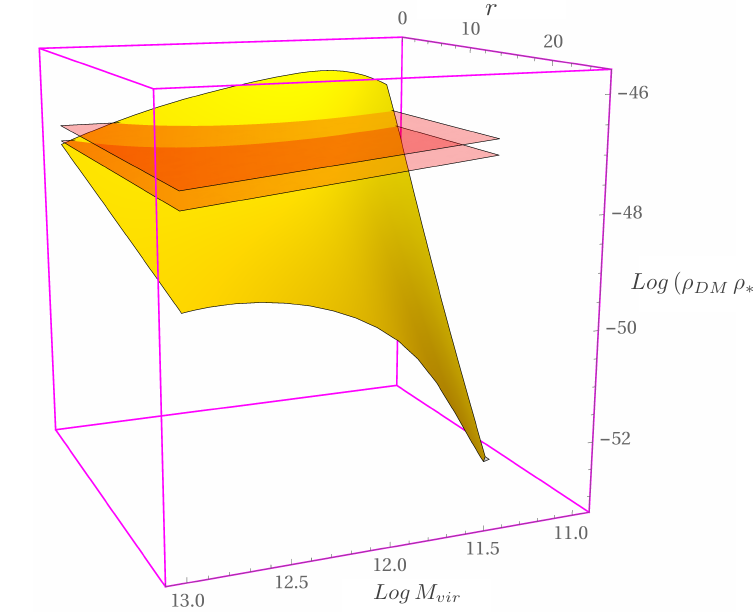
Figure 4. log K C / ( g 2 cm − 6 ) as function of log M vir / M range of K C ( r 0 ) lies between the two parallel